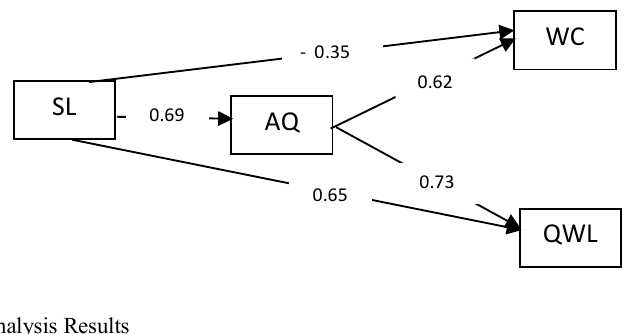
Figure 1: Path Analysis Results